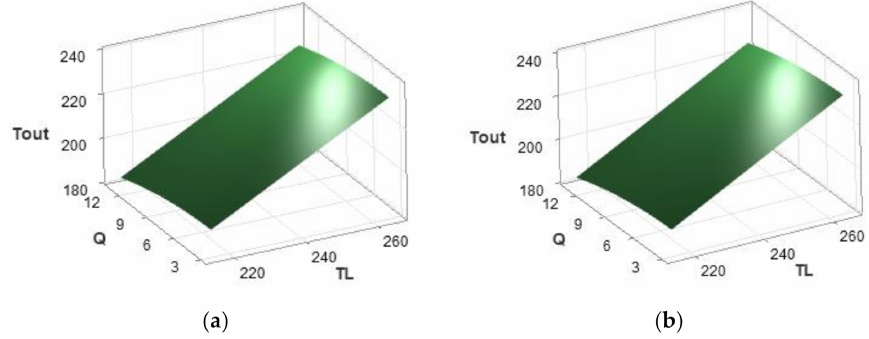
Figure 6. Results of response surface analysis for predicting T out for ( a ) PLA ( b )